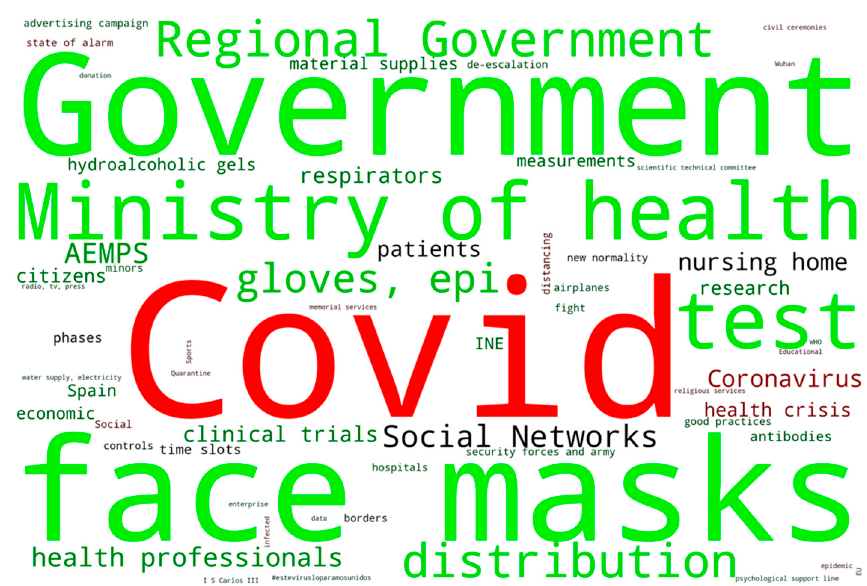
Figure 4. Word cloud generated from the press releases of the Ministry of Health during the period 1